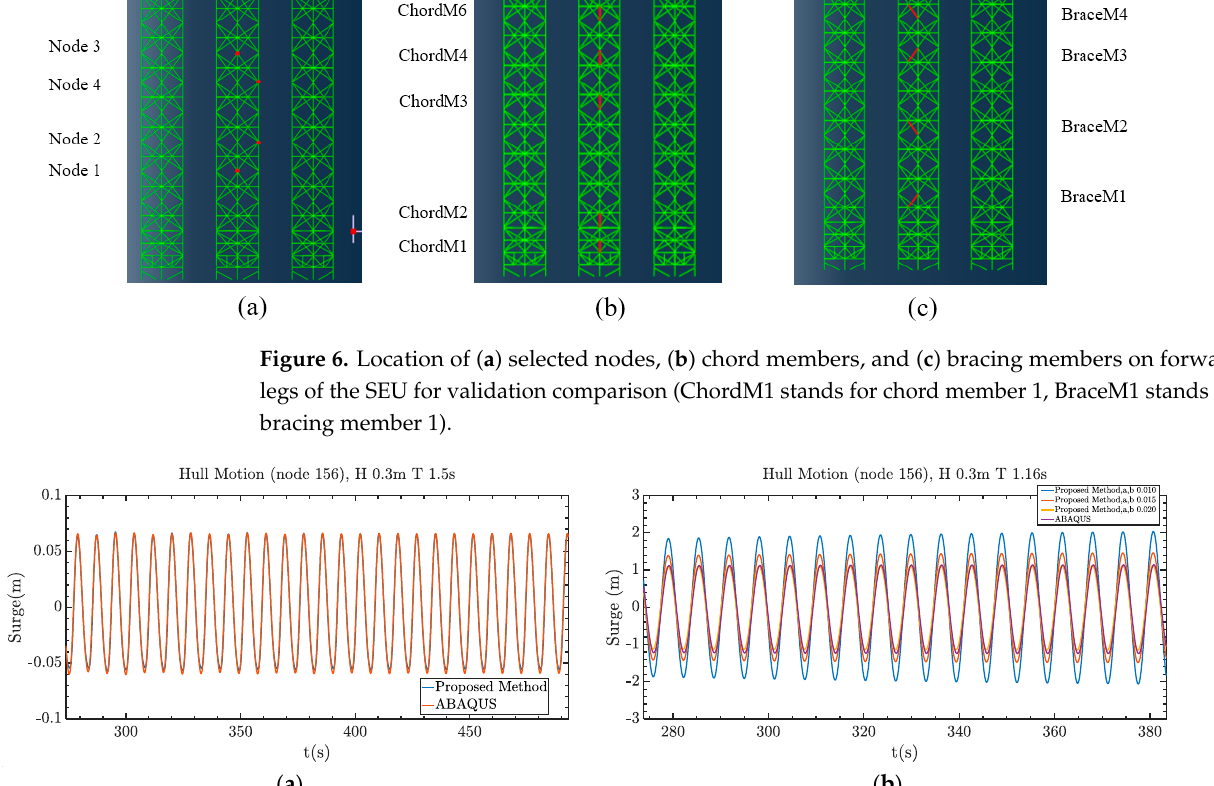
Figure 7. Comparison of the time history of hull displacement in surge under regular wave excita- tions outside and inside the resonant frequency range ( a , b ).